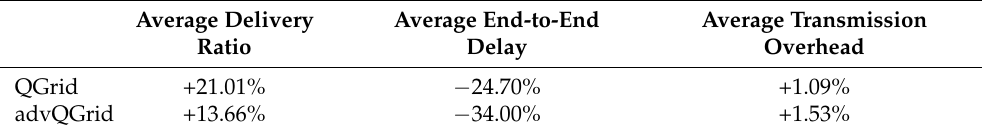
Table 10. Performance improvement of SD-QGrid compared to routing protocols with TTLs.